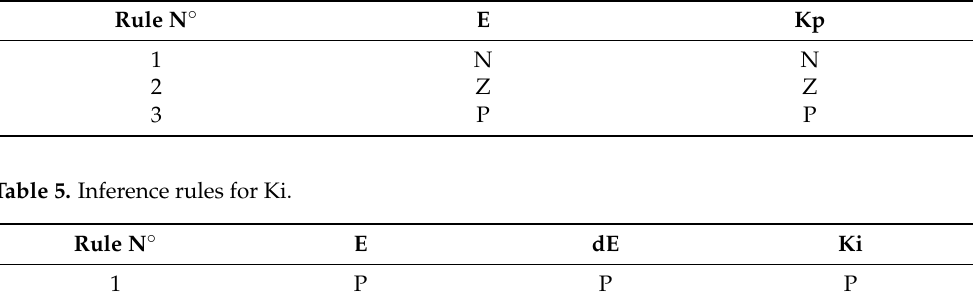
Table 5. Inference rules for Ki.